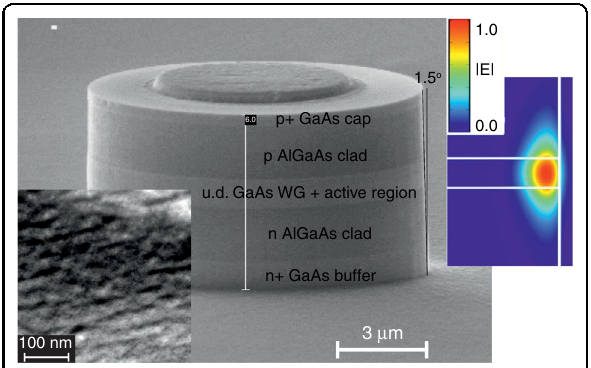
Fig. 1 Microdisk laser. Main panel: SEM image of QD-on-GaAs microdisk with top contacts. Insets: plan-view TEM image of QWD array (left panel); electric fi eld distribution (right